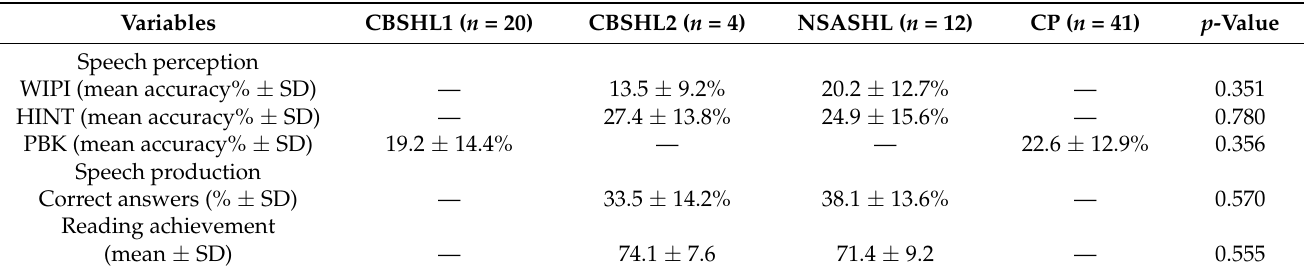
Table 2. Investigations before cochlear